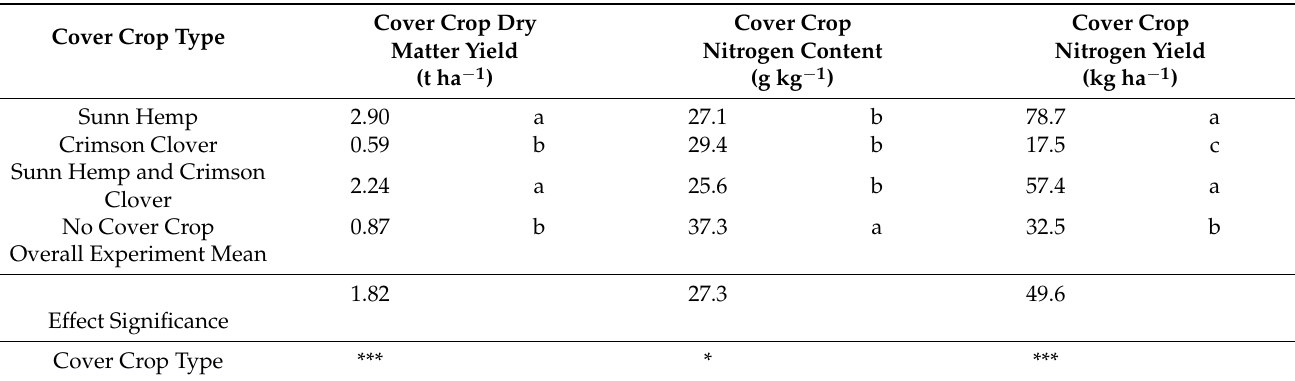
Table 2. Mean cover crop dry matter biomass and nitrogen content following different cover crops in South Deerfield MA in 2014–2015 and